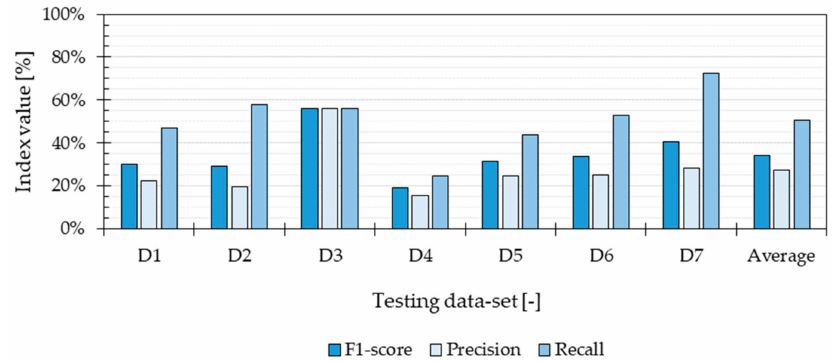
Figure 4. Overall performance of the method when the Application approach was used, which accounts for the data from the seven dwellings (D1, D2, D3, D4, D5, D6 and D7) evaluated in the field